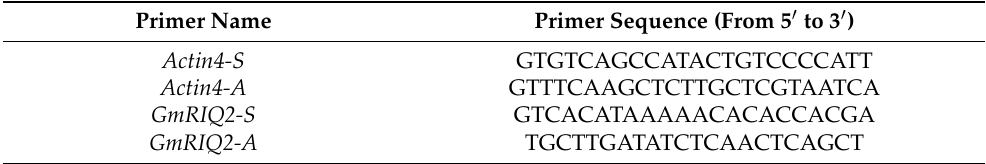
Table 3. Primers used for